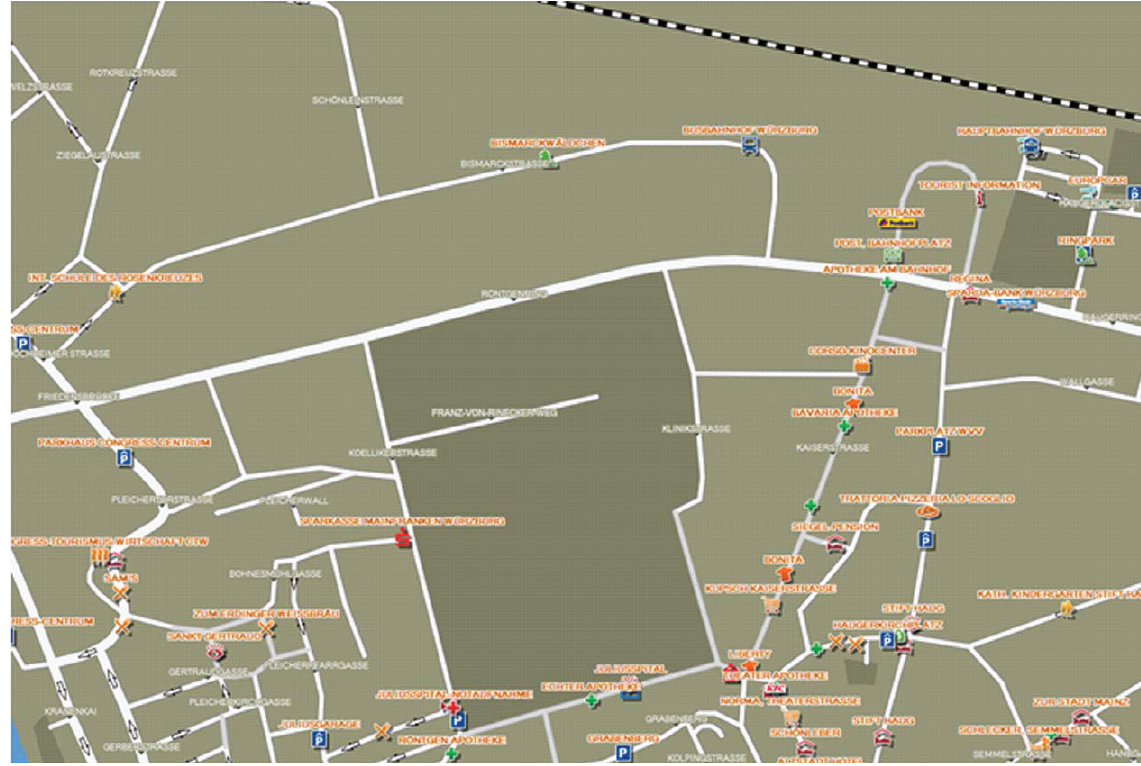
Fig. 8. Part of the test area W ¨ urzburg: map without pedestrian